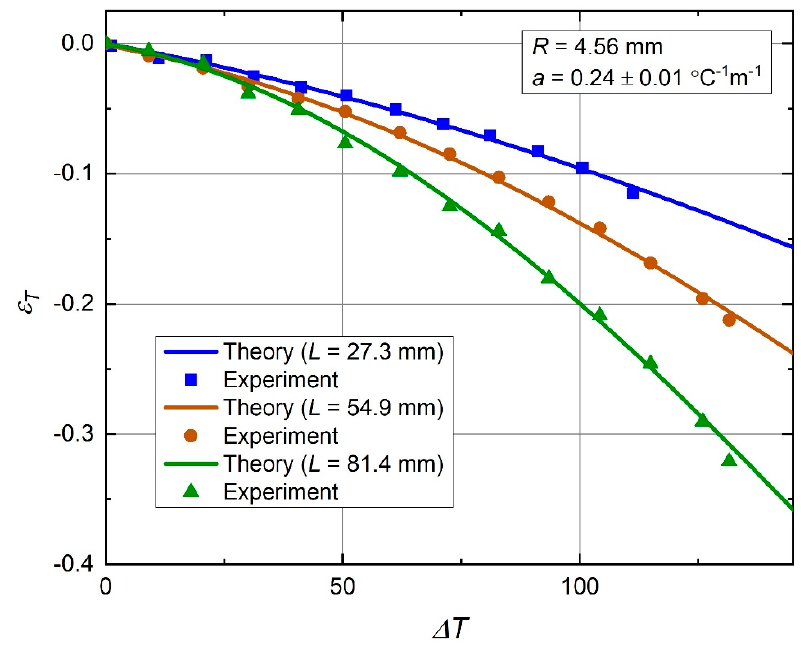
ε T ) with temperature: present theory and